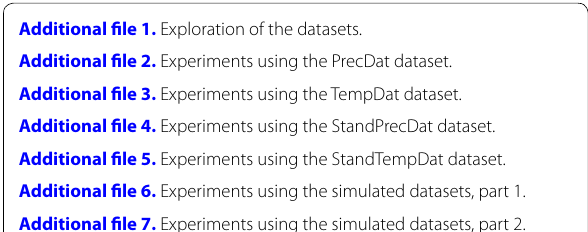
The minimum of the minimum values and the maximum of the maximum values are in italic